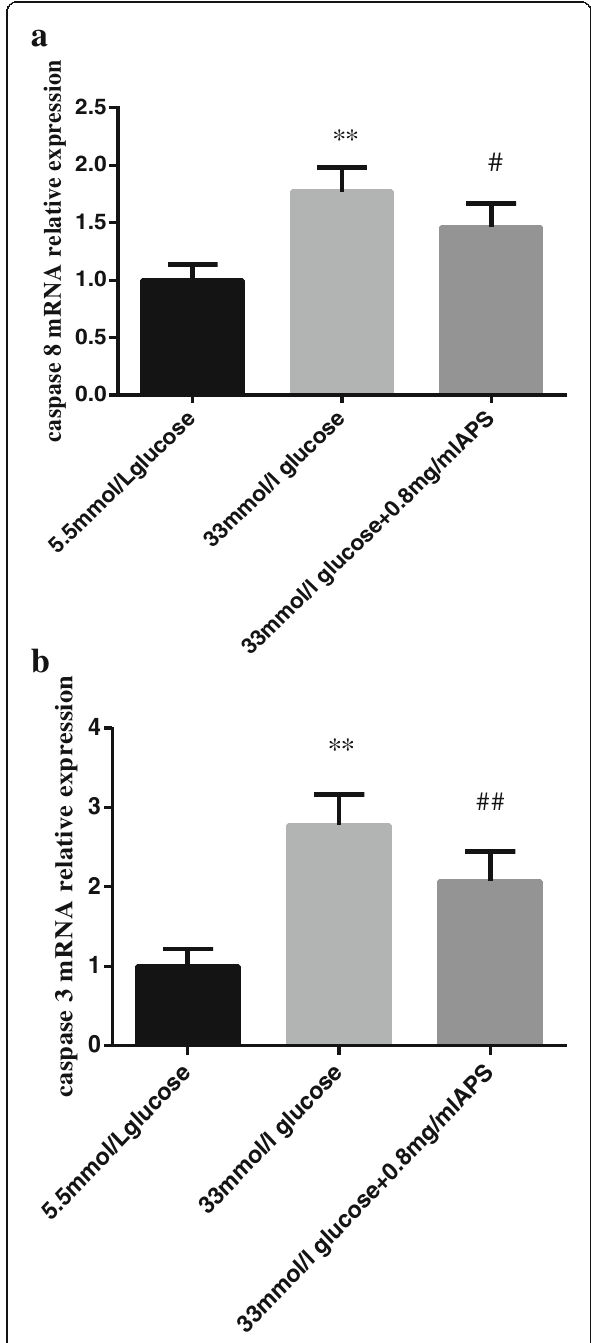
Fig. 4 APS modulated the mRNA expression levels of extrinsic apoptotic pathway-related factors. H9C2 cells were pre-incubated with/without APS for 24 h and then treated with 33 mmol/L glucose for 24 h. The expression of GAPDH was measured as an internal control. a . the relative mRNA expression levels of caspase 8 in different groups. b . the relative mRNA expression levels of caspase 3 in different groups. Data were expressed as Mean ± SD. ** P < 0.01 versus 5.5 mmol/L glucose group; # P < 0.05 versus 33 mmol/L glucose group. ## P < 0.01 versus 33 mmol/L glucose